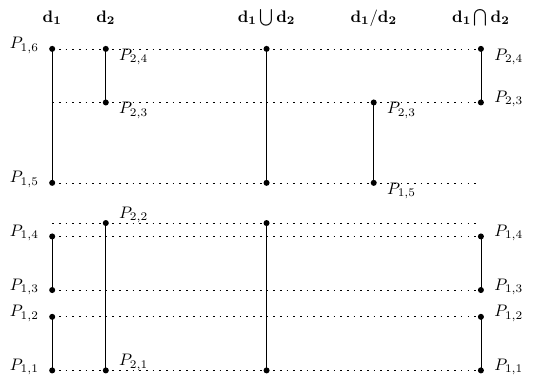
Figure 3. Boolean operations defined between dexels.